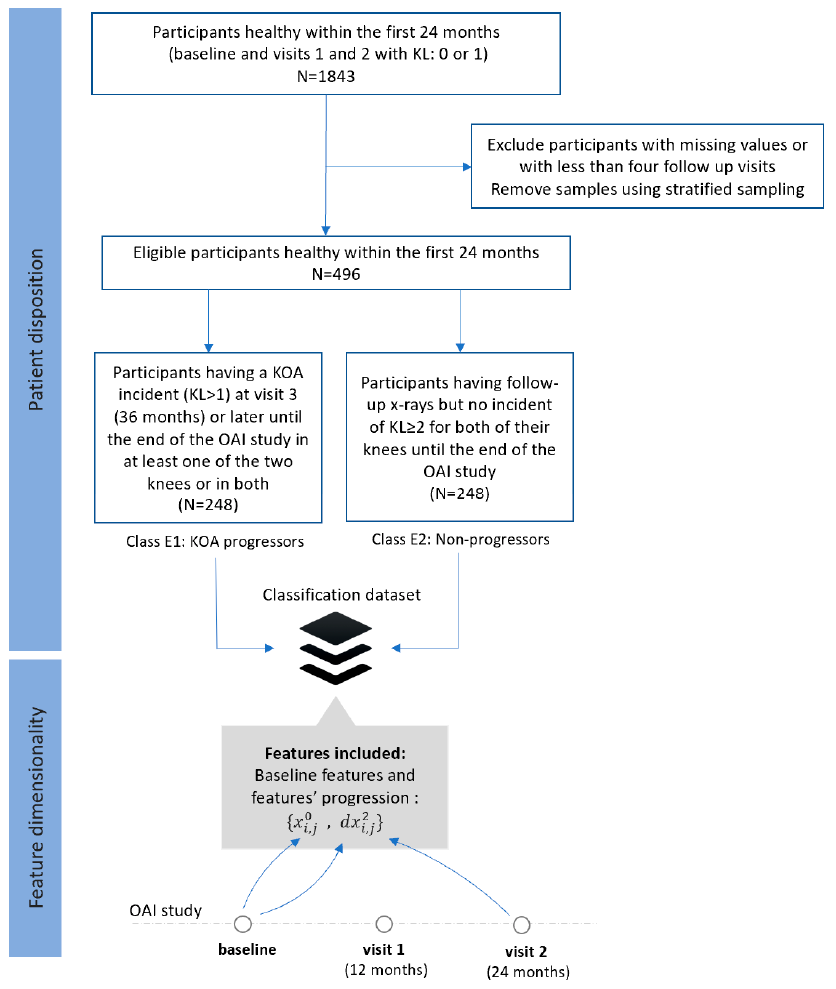
Figure 5. Flow chart of study design for dataset E.